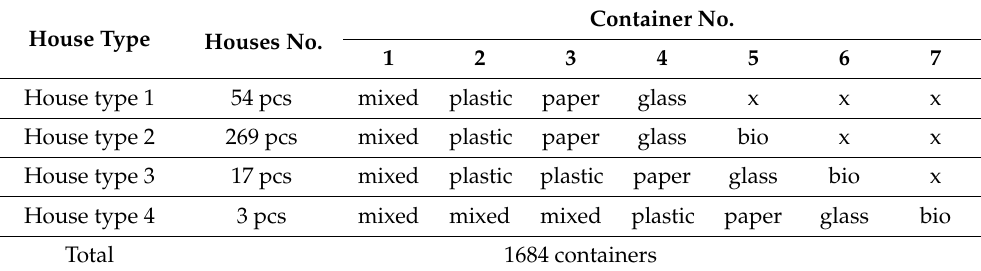
Table 1. Types of waste in